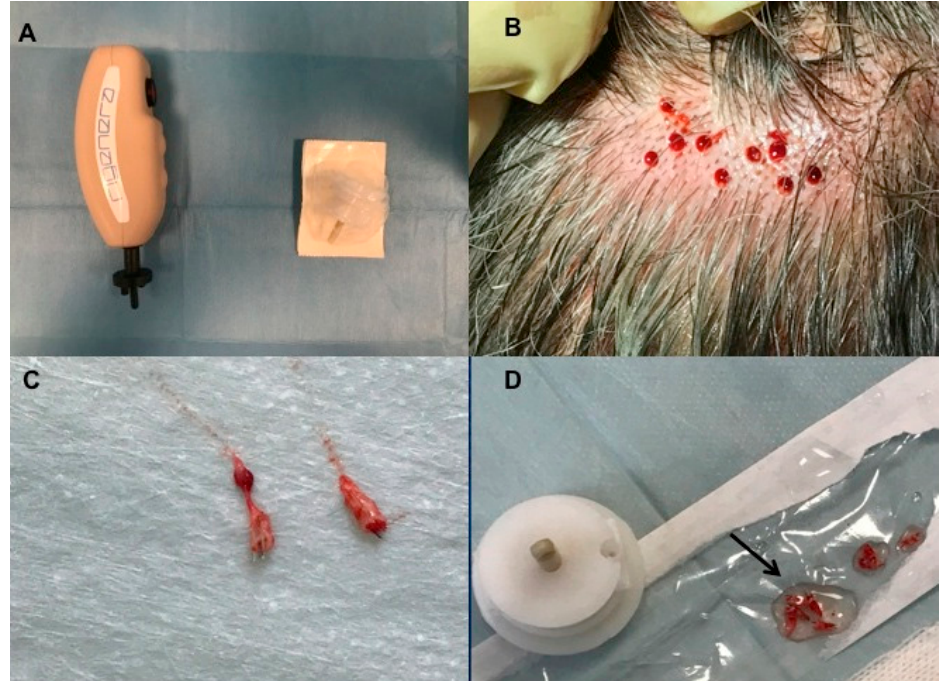
Figure 2. Micro-graft procedure phase 1. ( A ) On the left, Rigenera Securdrill device and on the right Rigeneracons kit; ( B ) The holes in the scalp after punch biopsy; ( C ) Selected scalp tissues into the strips (2 × 2 mm); ( D ) The authors controlled the presence of bulb in the selected tissue and conserved the strips into saline solution. Biomedicines 2019 , 7 , 27